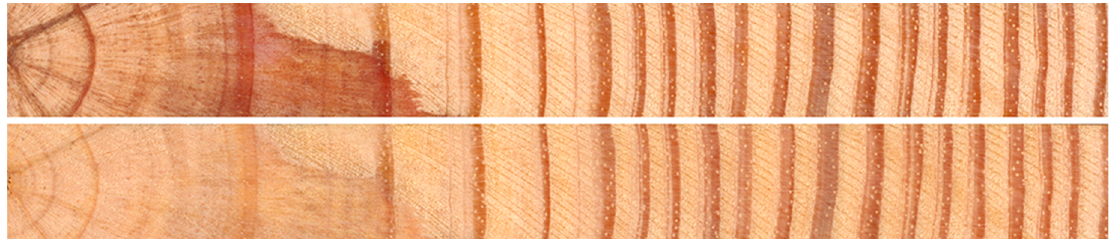
Figure 1. Loblolly pine radial strip before ( top ) and after ( bottom ) extraction.